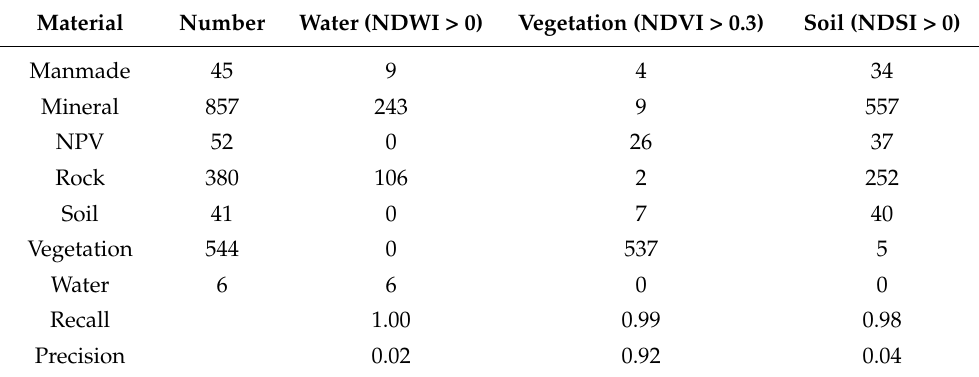
Table 1. Number of spectra identified as specified materials with different normalized difference indices (NDIs) using various threshold values on the ECOSTRESS spectral